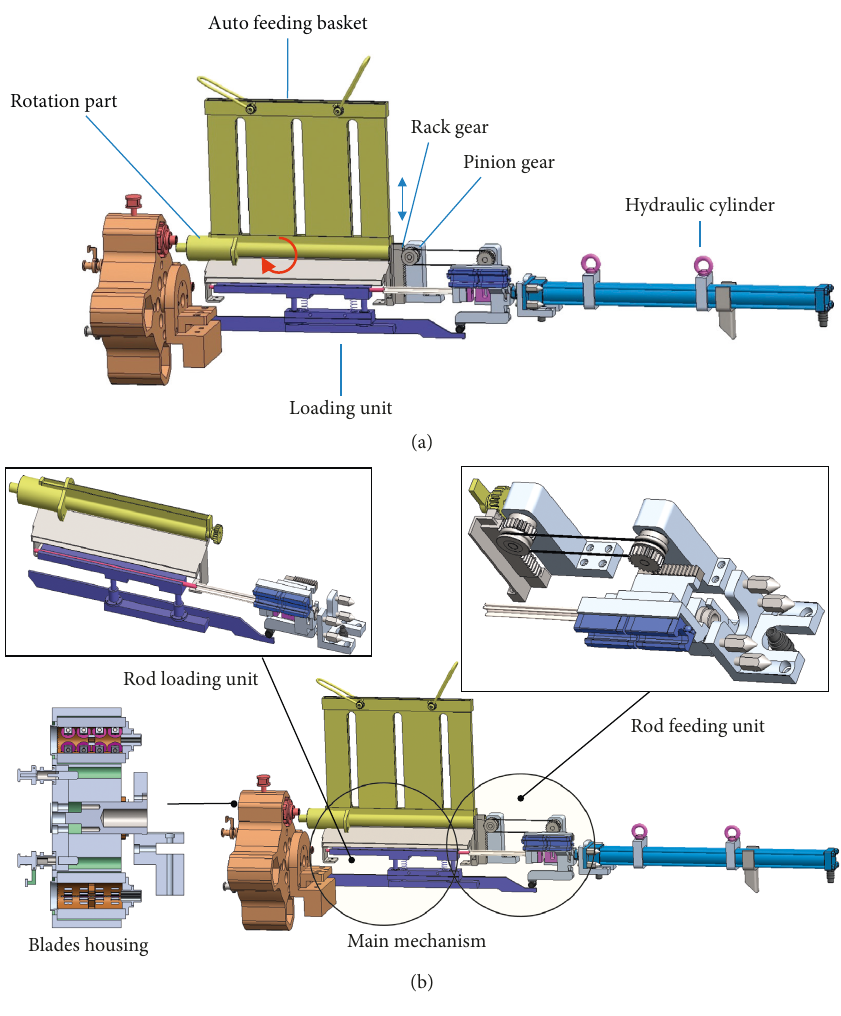
Figure 14: Main modules of practical scale mechanical decladder: (a) mechanism; (b) main modules.